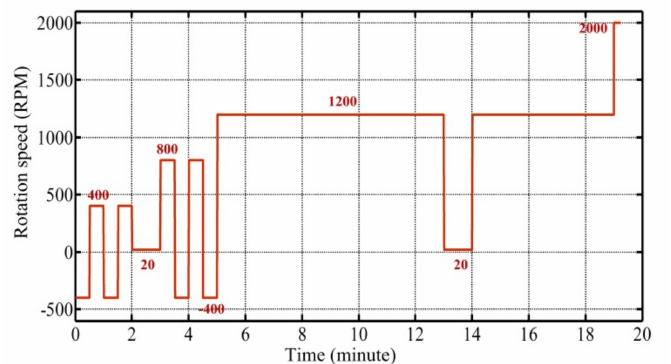
Figure 5. Spinning protocol in one salt-controlled ionic liquid dispersive liquid-liquid microextraction (SC-IL-DLLME)